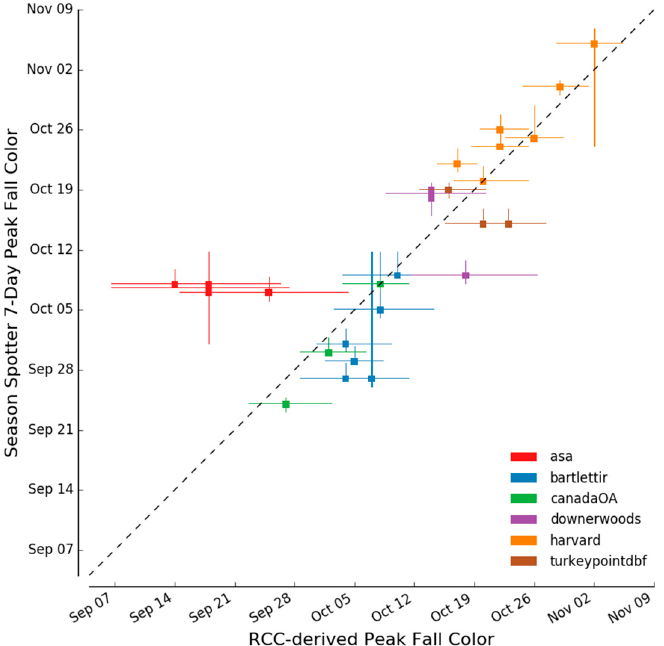
Figure 12. Comparison between the date of maximum R CC value and the date of peak autumn color calculated from Season Spotter.